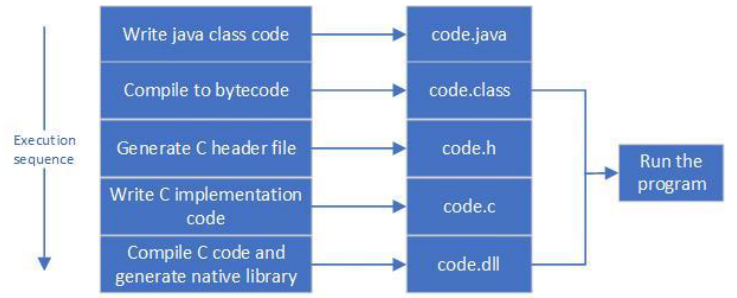
Figure 4. Implementation frame of the five algorithms by using Java Native Interface (JNI).